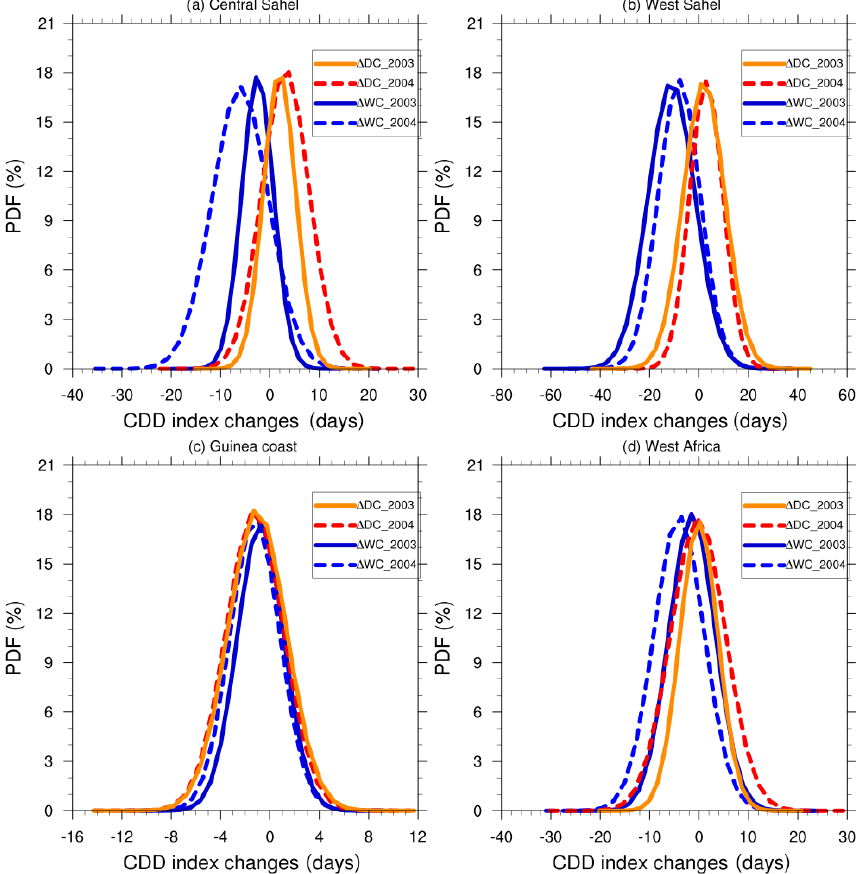
Figure 7. Same as Fig. 3 but for the CDD index (in